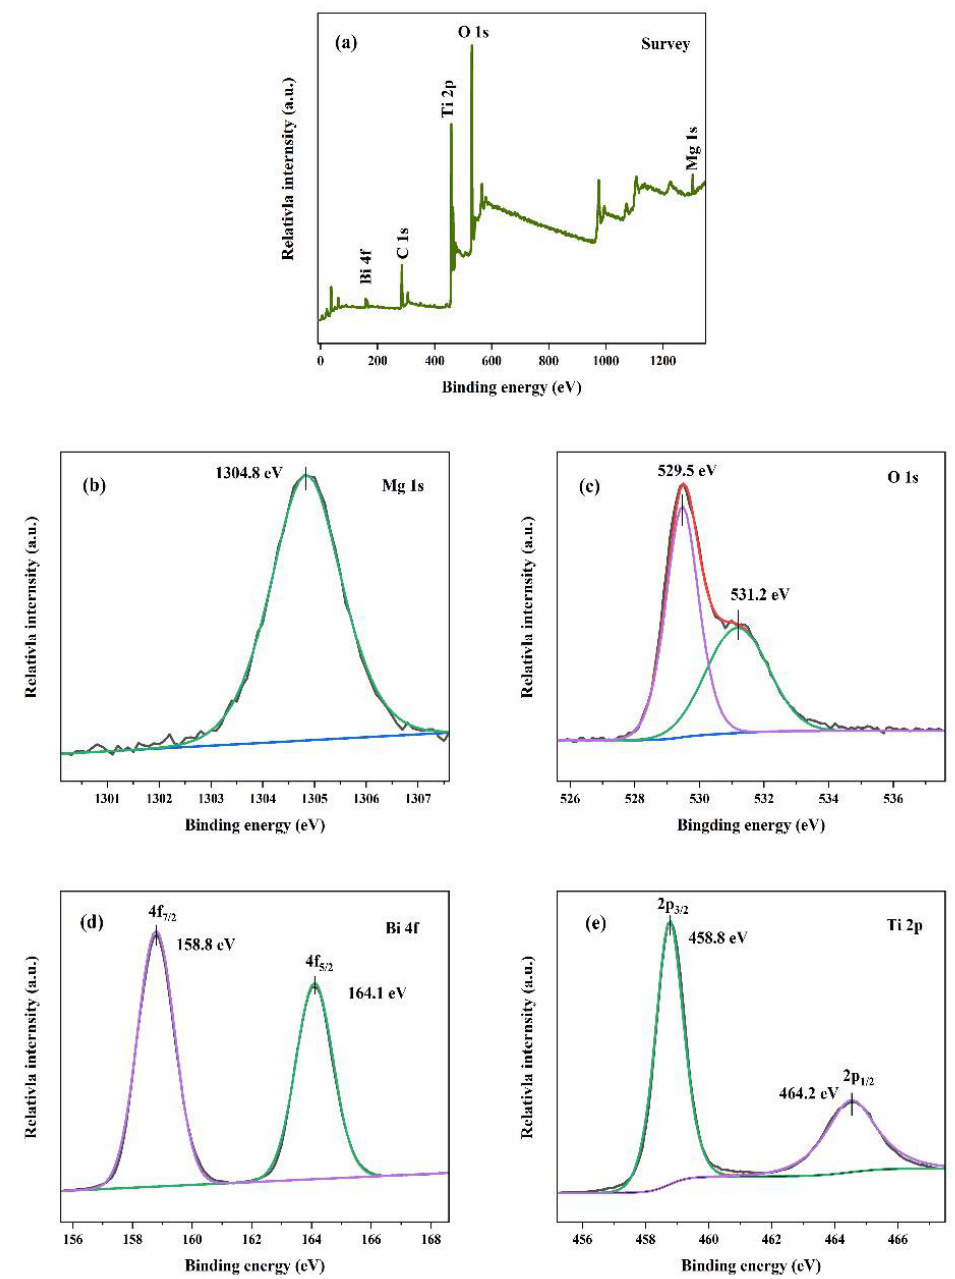
Figure 3. XPS spectra of 0.2 MBO/TiO 2 : ( a ) full scan survey of all the elements; ( b ) Mg1s; ( c ) O1s; ( d ) Bi4f; ( e ) Ti2p.